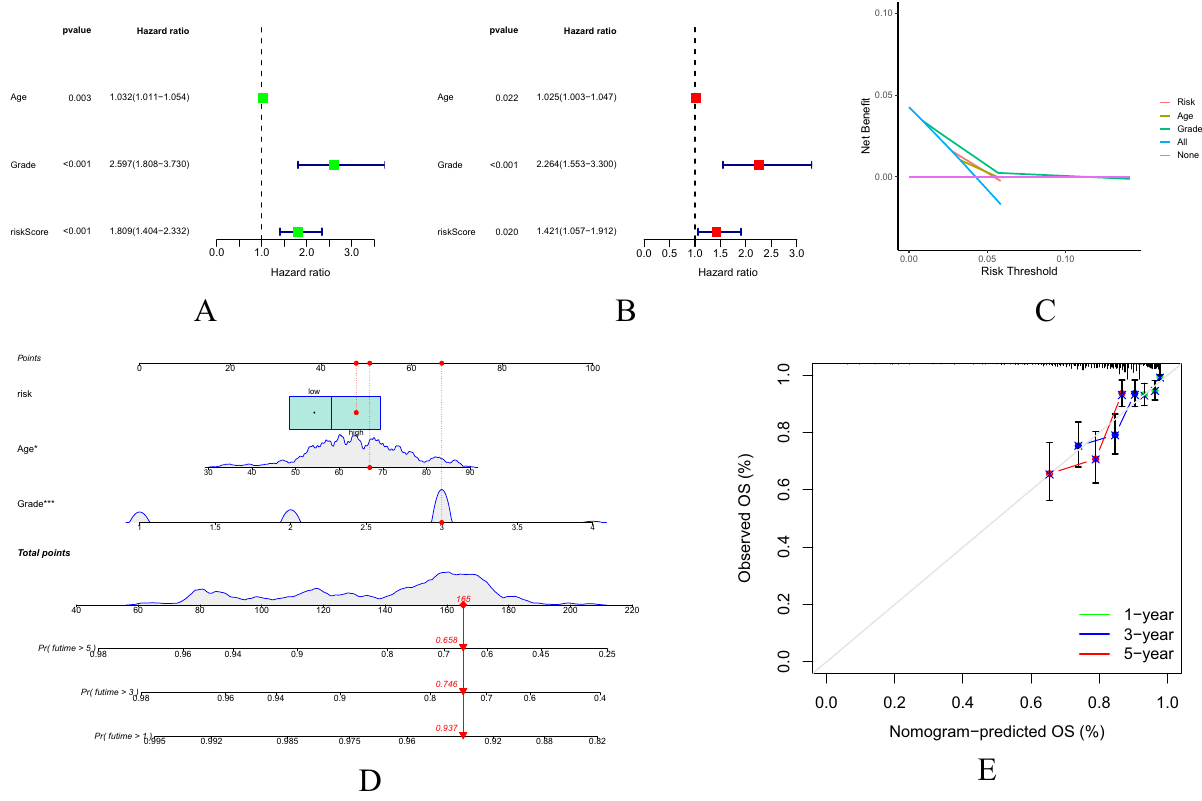
Figure 5. Independent prognostic analysis of risk score model. ( A,B ) Univariate and multivariate COX regression analysis of OS in the TCGA cohort. ( C ) DCA curve of scores and score-clinical variable integration mode. ( D ) Survival prognosis nomogram of UCEC patients. ( E ) Calibration charts for predicting 1, 3 and 5-year survival of UCEC